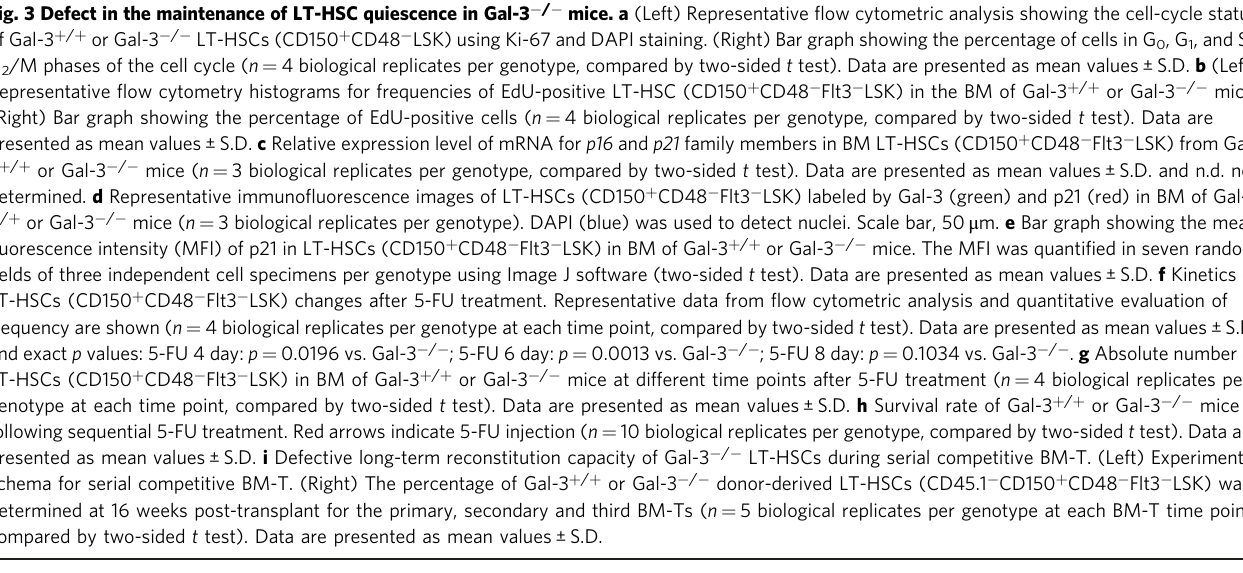
Fig. 3 Defect in the maintenance of LT-HSC quiescence in Gal-3 − / − mice. a (Left) Representative fl ow cytometric analysis showing the cell-cycle status of Gal-3 + / + or Gal-3 − / − LT-HSCs (CD150 + CD48 − LSK) using Ki-67 and DAPI staining. (Right) Bar graph showing the percentage of cells in G 0 , G 1 , and S/ G 2 /M phases of the cell cycle ( n = 4 biological replicates per genotype, compared by two-sided t test). Data are presented as mean values± S.D. b (Left) Representative fl ow cytometry histograms for frequencies of EdU-positive LT-HSC (CD150 + CD48 − Flt3 − LSK) in the BM of Gal-3 + / + or Gal-3 − / − mice. (Right) Bar graph showing the percentage of EdU-positive cells ( n = 4 biological replicates per genotype, compared by two-sided t test). Data are presented as mean values± S.D. c Relative expression level of mRNA for p16 and p21 family members in BM LT-HSCs (CD150 + CD48 − Flt3 − LSK) from Gal- 3 + / + or Gal-3 − / − mice ( n = 3 biological replicates per genotype, compared by two-sided t test). Data are presented as mean values ± S.D. and n.d. not determined. d Representative immuno fl uorescence images of LT-HSCs (CD150 + CD48 − Flt3 − LSK) labeled by Gal-3 (green) and p21 (red) in BM of Gal-3 + / + or Gal-3 − / − mice ( n = 3 biological replicates per genotype). DAPI (blue) was used to detect nuclei. Scale bar, 50 μ m. e Bar graph showing the mean fl uorescence intensity (MFI) of p21 in LT-HSCs (CD150 + CD48 − Flt3 − LSK) in BM of Gal-3 + / + or Gal-3 − / − mice. The MFI was quanti fi ed in seven random fi elds of three independent cell specimens per genotype using Image J software (two-sided t test). Data are presented as mean values± S.D. f Kinetics of LT-HSCs (CD150 + CD48 − Flt3 − LSK) changes after 5-FU treatment. Representative data from fl ow cytometric analysis and quantitative evaluation of frequency are shown ( n = 4 biological replicates per genotype at each time point, compared by two-sided t test). Data are presented as mean values ± S.D. and exact p values: 5-FU 4 day: p = 0.0196 vs. Gal-3 − / − ; 5-FU 6 day: p = 0.0013 vs. Gal-3 − / − ; 5-FU 8 day: p = 0.1034 vs. Gal-3 − / − . g Absolute number of LT-HSCs (CD150 + CD48 − Flt3 − LSK) in BM of Gal-3 + / + or Gal-3 − / − mice at different time points after 5-FU treatment ( n = 4 biological replicates per genotype at each time point, compared by two-sided t test). Data are presented as mean values ± S.D. h Survival rate of Gal-3 + / + or Gal-3 − / − mice following sequential 5-FU treatment. Red arrows indicate 5-FU injection ( n = 10 biological replicates per genotype, compared by two-sided t test). Data are schema for serial competitive BM-T. (Right) The percentage of Gal-3 + / + or Gal-3 − / − donor-derived LT-HSCs (CD45.1 − CD150 + CD48 − Flt3 − LSK) was determined at 16 weeks post-transplant for the primary, secondary and third BM-Ts ( n = 5 biological replicates per genotype at each BM-T time